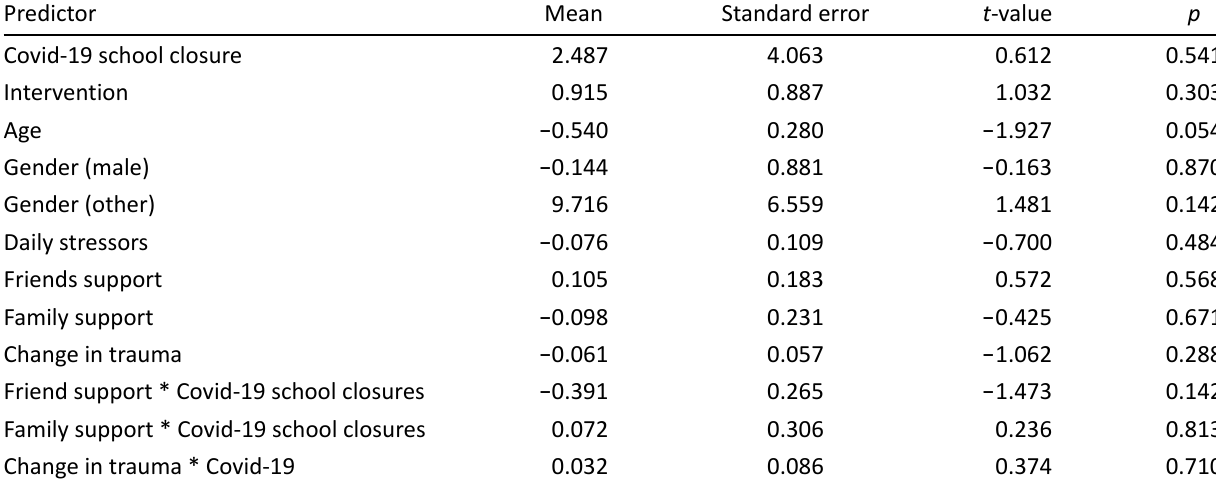
Table 3. The effect of Covid‐19, post‐traumatic stress symptoms, social support, and socio‐demographic characteristics in the change in school belonging.